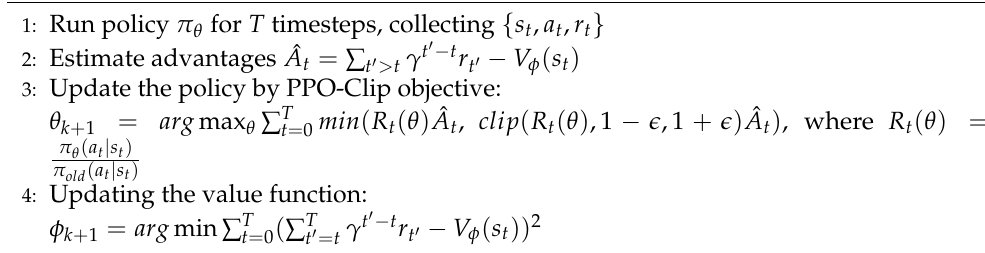
Algorithm 2 Proximal policy optimization (PPO).